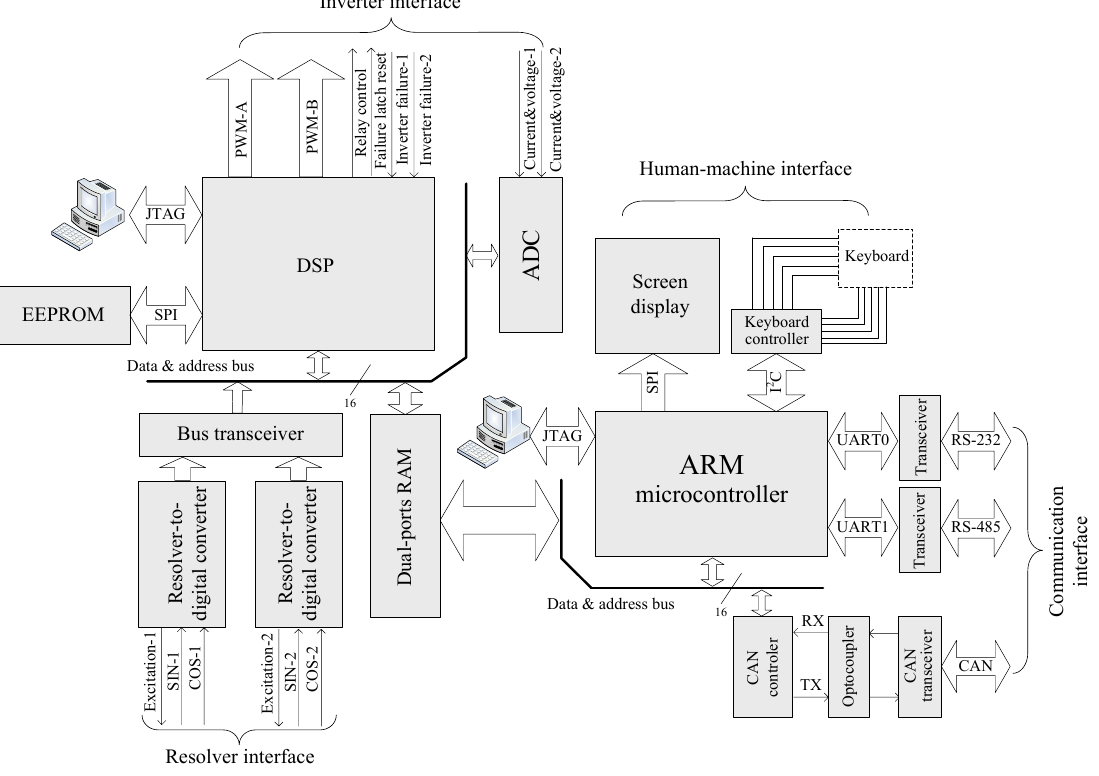
Figure 9. Hardware implementation of the flux-modulated CS-PMSM controller.